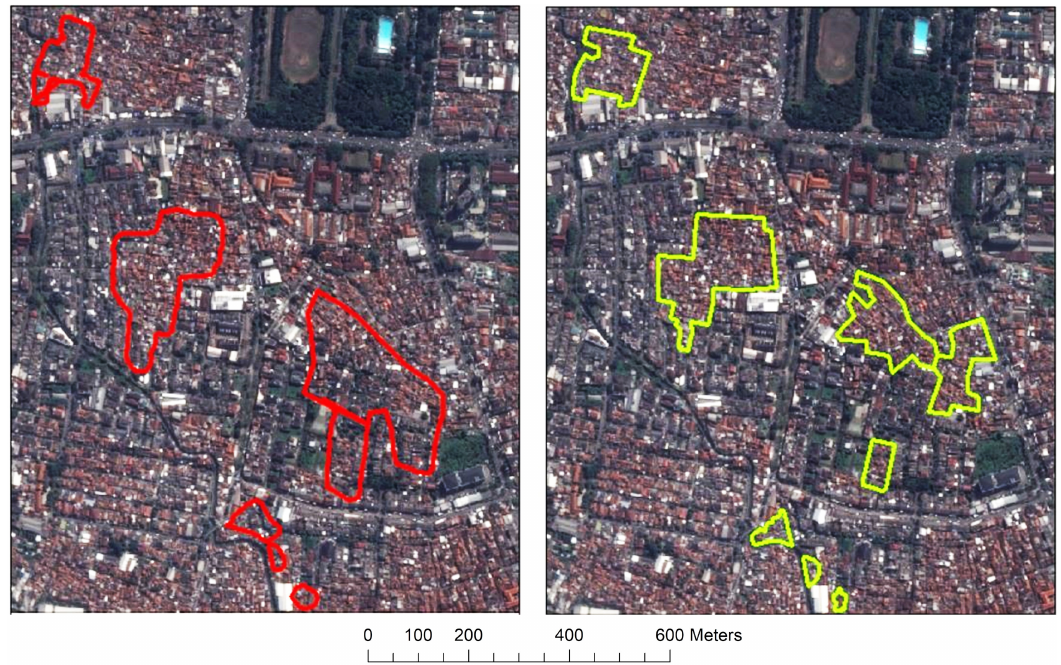
Figure 11. Difference between slum maps produced by the local mapping team of the Indonesian Government ( left ) and a combination of ground survey and image interpretation ( right ) [71] (Image source: Pleiades provided via the ESA Third Party data